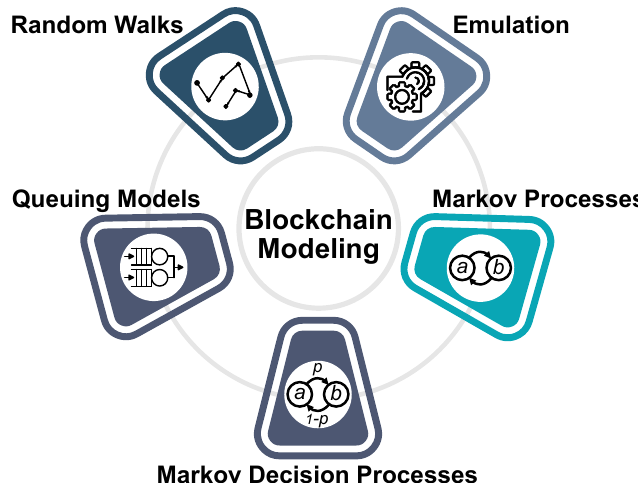
Figure 1. Proposed blockchain modeling approaches’